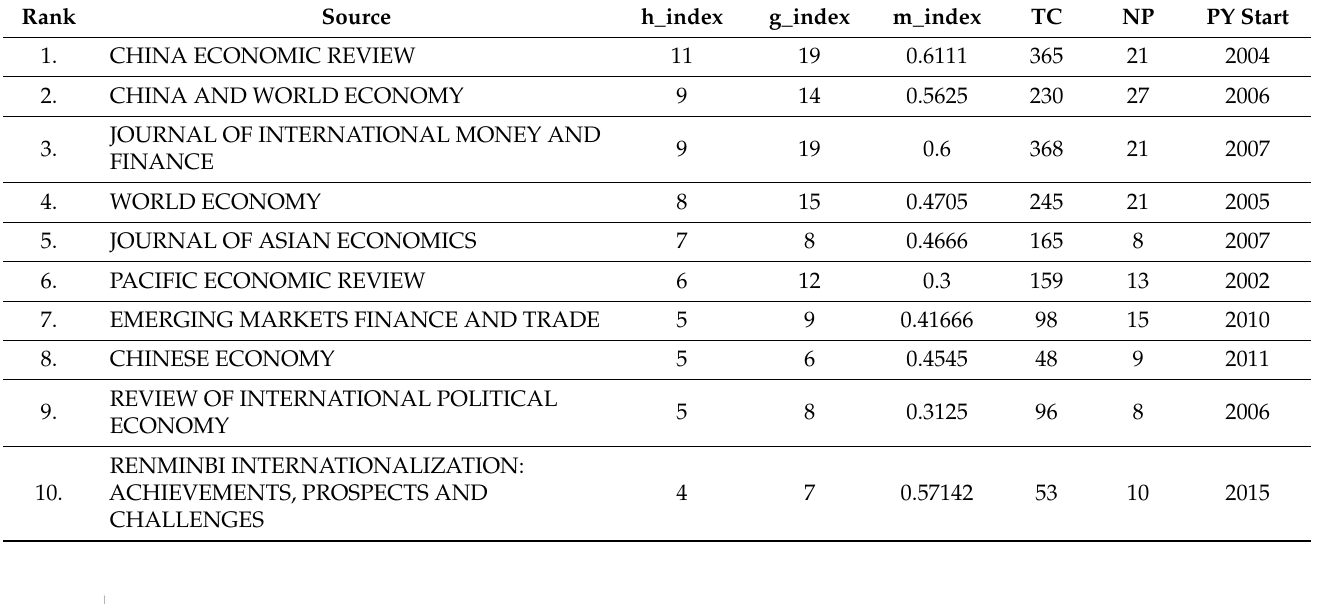
Table 1. Top 10 sources by source impact.